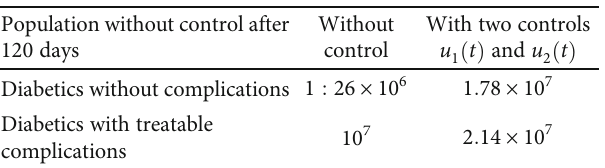
Figure 3: The evolution of the number of diabetics with and without complications without controls. Table 3: Evolution of the number of diabetics with two controls